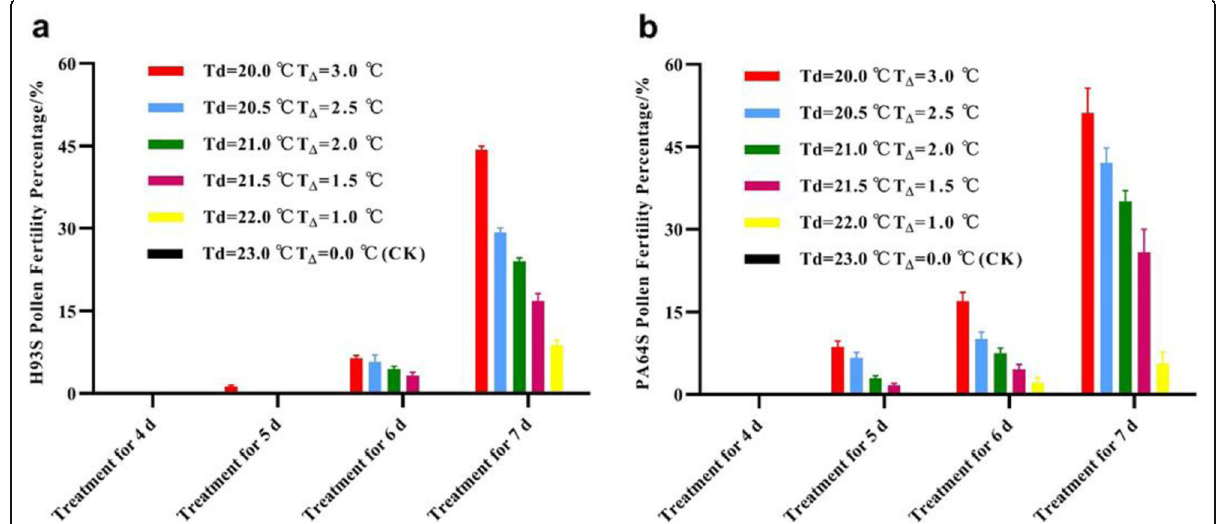
Fig. 2 Pollen fertility of H93S and PA64S with different treatment days and different T Δ values with a 13.5 h photoperiod. a Pollen fertility of H93S. b Pollen fertility of PA64S (Table 4 includes the actual data